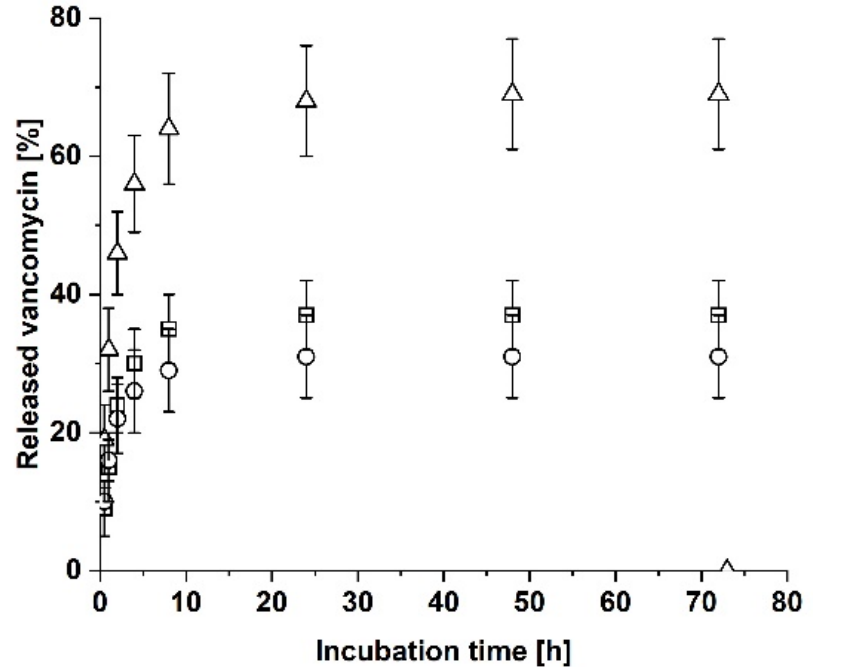
Figure 3. Release of vancomycin from a sheet of RGX-modified Atelocollagen that was placed in the sample holder. Atelocollagen was loaded with vancomycin and the release in the upper cavity (squares), the lower cavity (dots) and in total (triangles) was analyzed. After 72 h, the collagen sheet was incubated for an additional hour in PBS without the sample holder. The error bars represent the standard deviation ( n = 3).